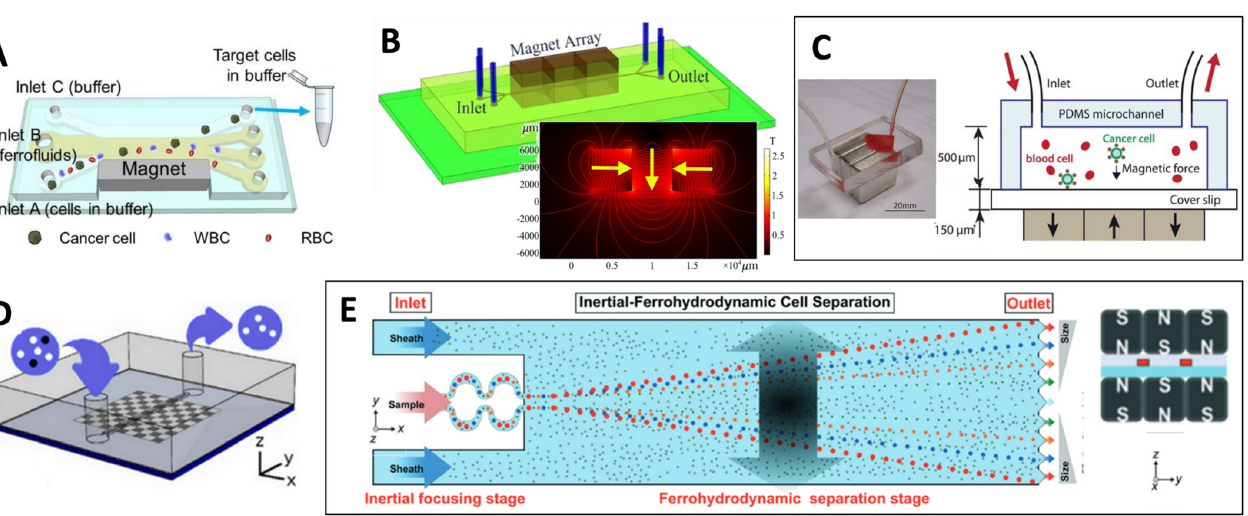
Figure 11. Macroscale permanent magnets in microfluidic separation devices. ( A ) Illustration of a simple magnet separation device exerting a negative magnetophoretic force on CTCs and WBCs and a positive force on RBCs in a ferrofluid. Reprinted from [77], with the permission of Royal Society of Chemistry; permission conveyed through Copyright Clearance Center, Inc. ( B ) Illustration of Halbach configuration; distribution of the magnetic field from one side to farther distances. Reprinted with permission from [71]. Copyright 2020 American Chemical Society. ( C ) Picture (scale bare is 20 mm) and schematic illustration of a microfluidic device with three magnets with opposite polarities placed under the channel for CTCs isolation. Reprinted from [166], with the permission of Royal Society of Chemistry; permission conveyed through Copyright Clearance Center, Inc. ( D ) Illustration of an array of micromagnets obtained by thermomagnetic patterning of NdFeB hard magnetic film. Reprinted from [167], with the permission of AIP Publishing. ( E ) Schematic of inertial-ferrohydrodynamic cell separation. Six magnets, placed above and below the channel, create a maximum flux density at the center of the channel. Reprinted from [170] with the permission of Royal Society of Chemistry; permission conveyed through Copyright Clearance Center, Inc.